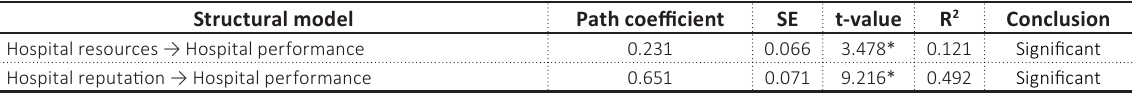
Table 4. Hypotheses testing